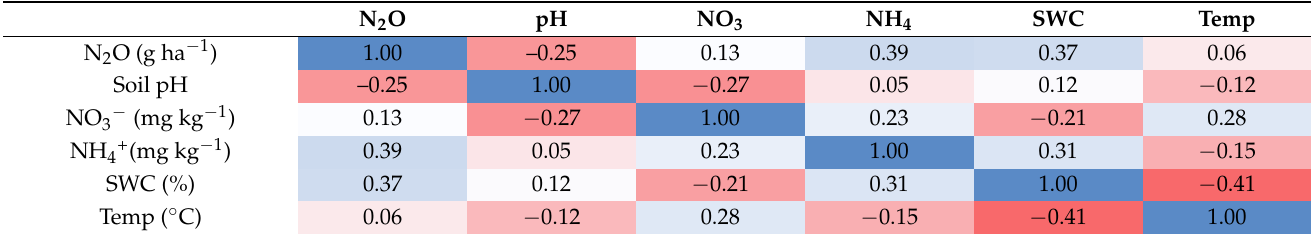
Table 6. Pearson correlation coefficients for all soil properties used in the PCA